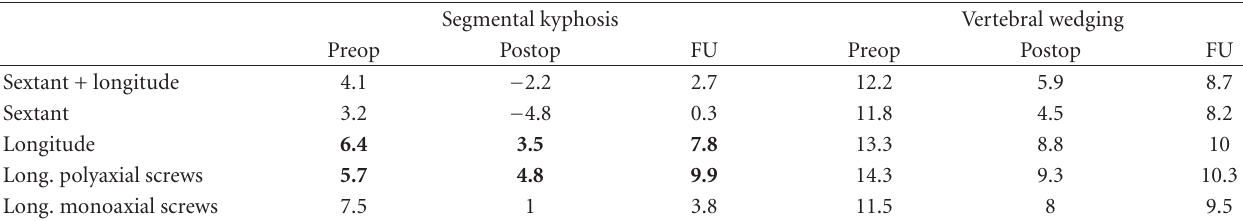
Table 2: Radiographic